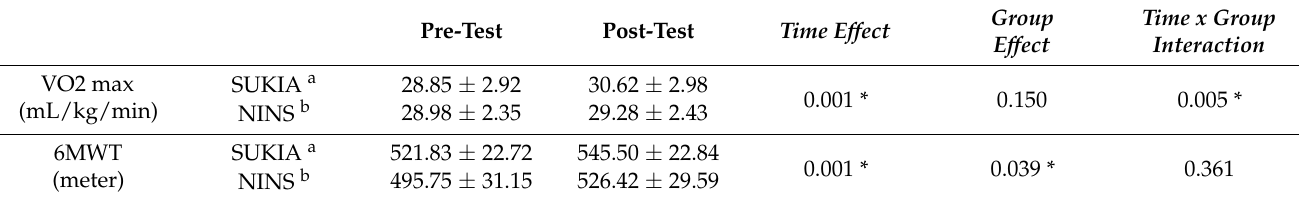
Table 5. VO2 max and 6 min walking test between SUKIA and NINS.